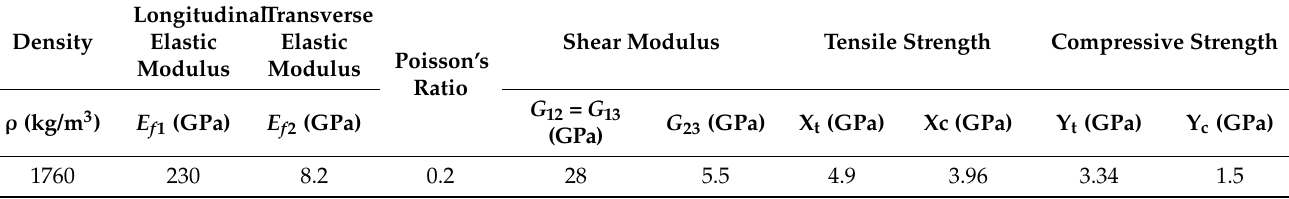
Table 1. Carbon fiber material parameters